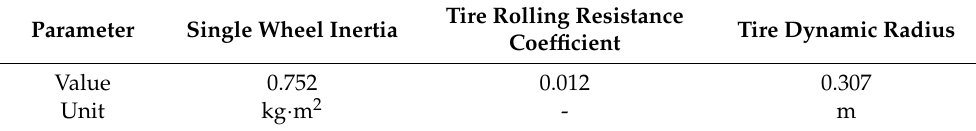
Table 4. Traction wheels parameters.